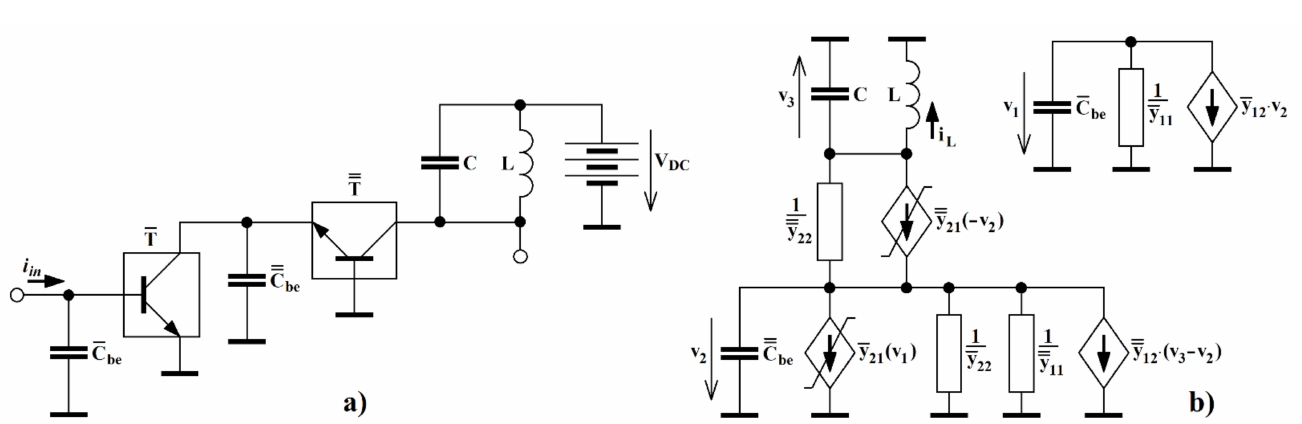
Figure 1. Simplified schematic of analyzed networks: ( a ) concept of driven cascaded resonant stage with non-ideal generalized bipolar transistors, ( b ) isolated circuit dedicated for calculations with equivalent models of generalized